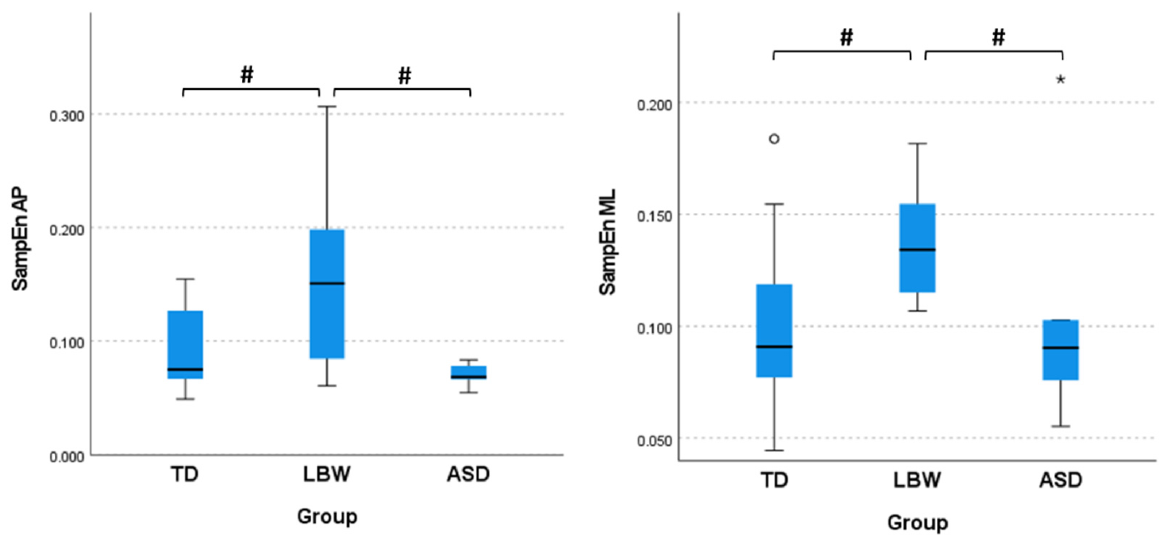
Figure 1. Sample entropy (SampEn) values in the anterior/posterior (AP) and medial/lateral (ML) directions at the onset of sitting posture. TD, infants with typical development; LBW, infants born prematurely and with low birth weight; ASD, infants with a sibling diagnosed with ASD. The # sign indicates significant differences between groups, while the * and ° denote outliers.